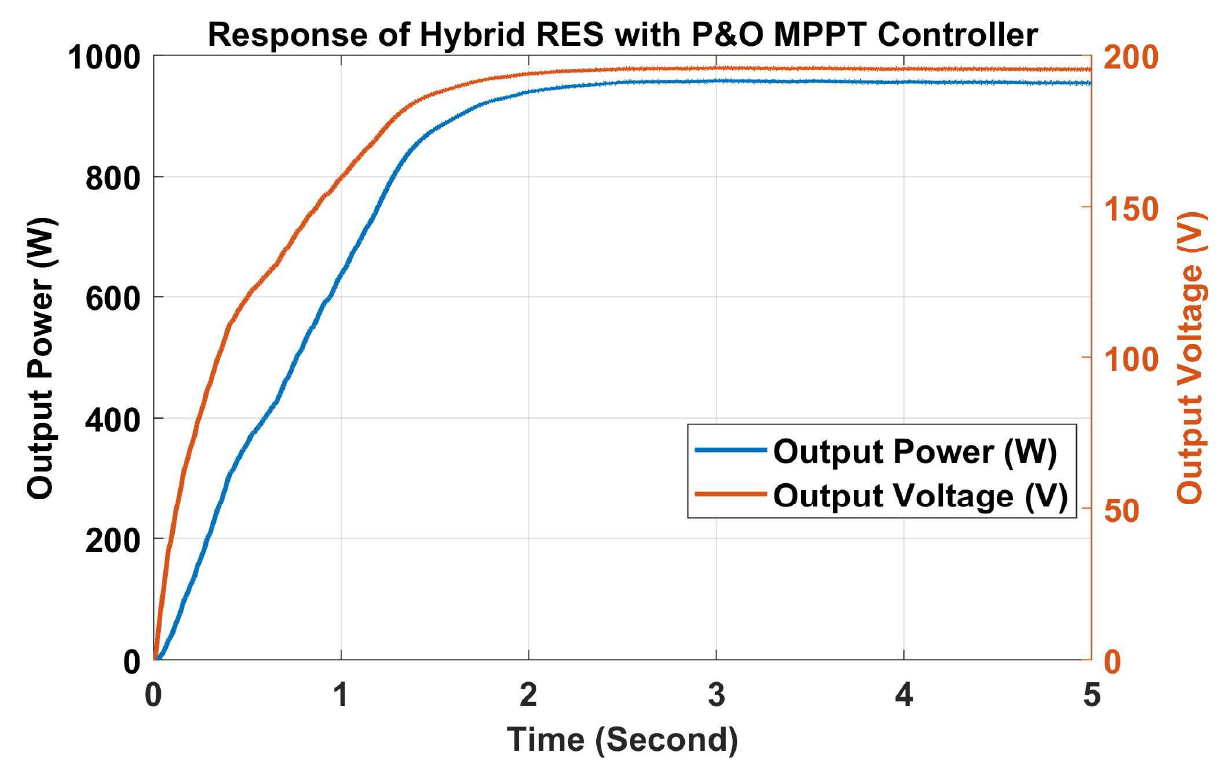
Figure 11. Output Power and Voltage of Hybrid RES with P-&-O MPPT.